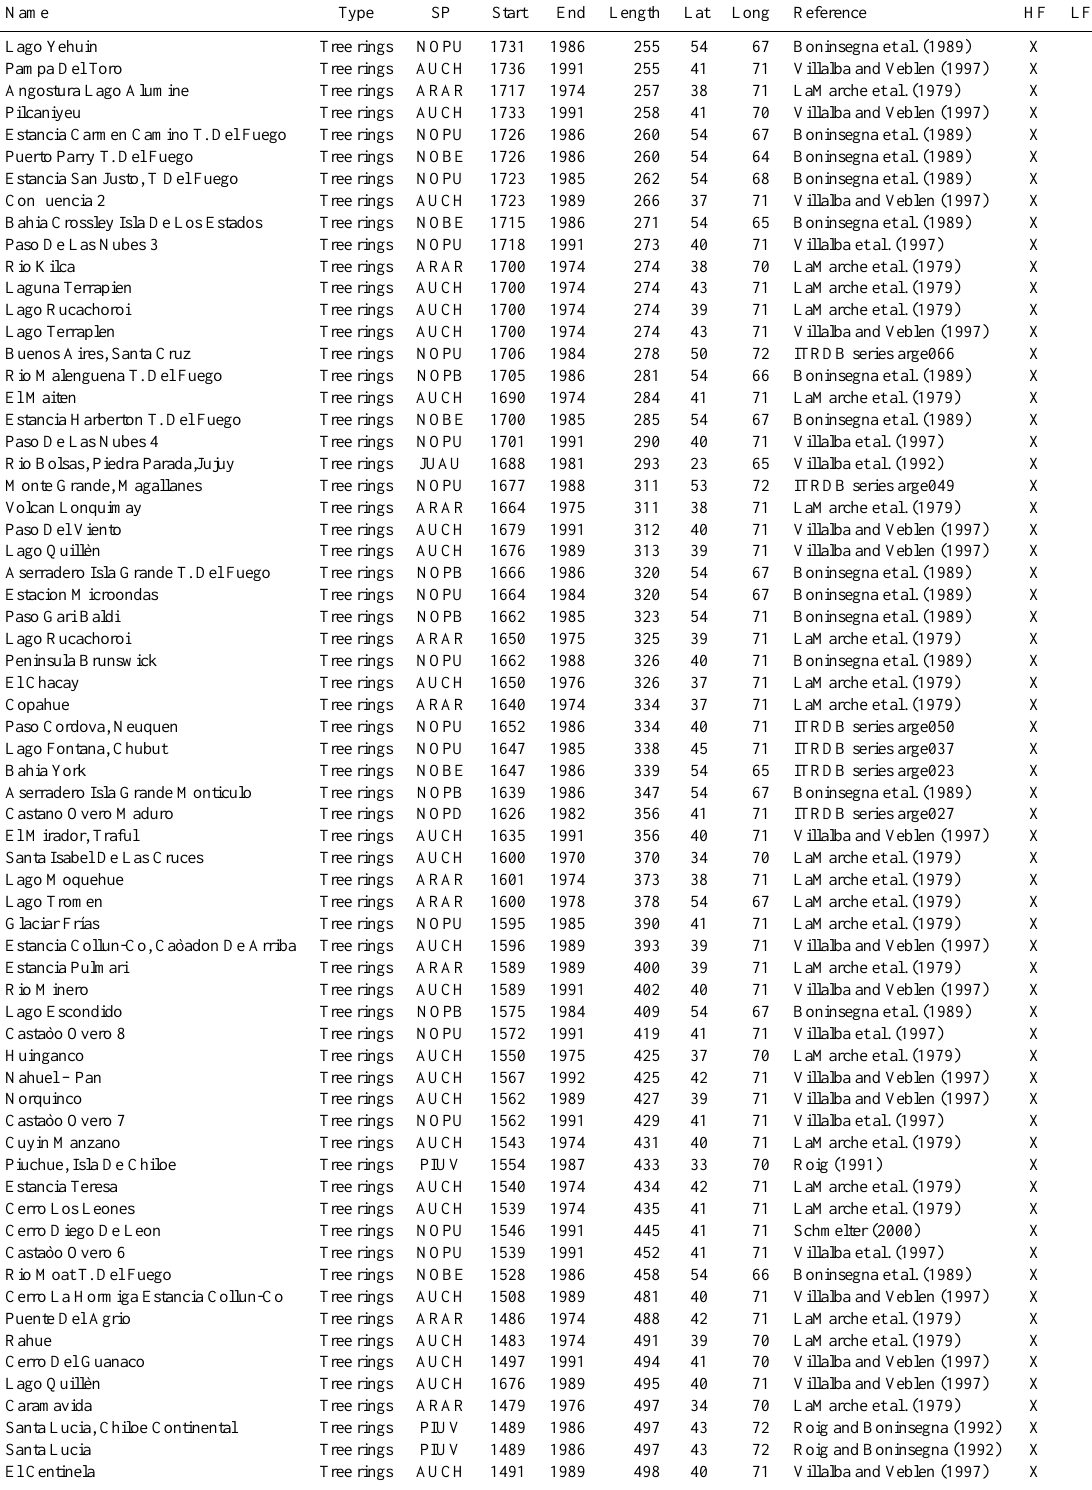
Table 1. The proxies used to reconstruct summer PDSI in SSA. HF=Proxies used to reconstruct the high frequency component (0 . 08 <f < 0 . 5). LF=Proxies used to reconstruct the low frequency component (0 <f < 0 .